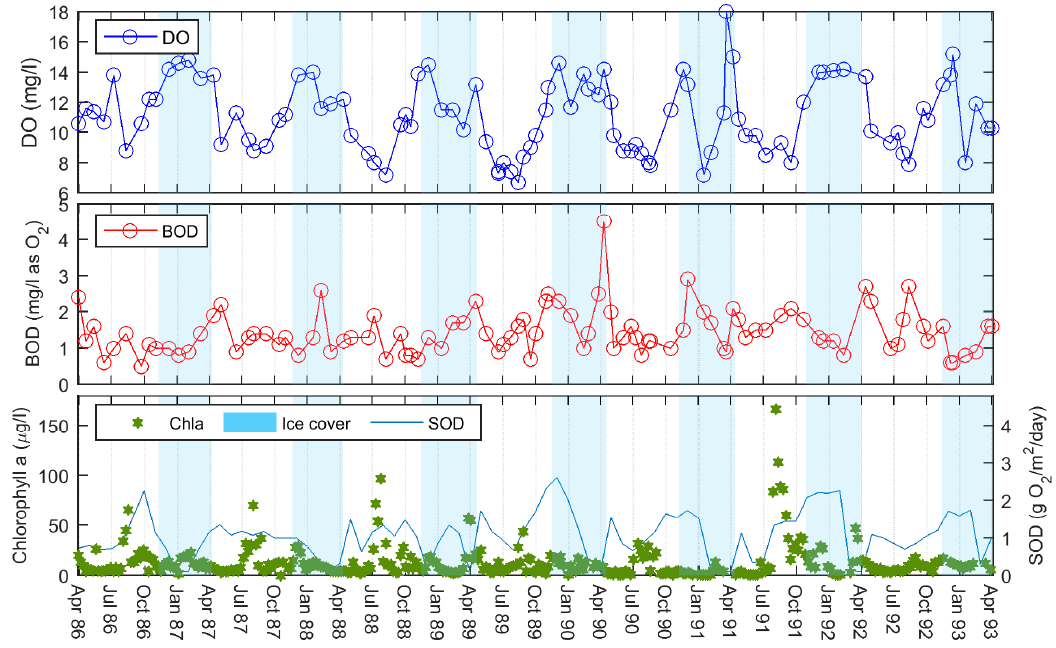
Figure 4. Observed dissolved oxygen (DO) and biochemical oxygen demand (BOD) inflow data, and in ‐ reservoir Chlorophyll ‐ a (Chla) concentrations in BPL. The DO and BOD data are monthly measurements at the upstream boundary (BOD as the standard five ‐ day BOD at 20 °C), and the Chla data are from the long ‐ term weekly dataset, provided by the Buffalo Pound Water Treatment Plant, at the downstream sample point.